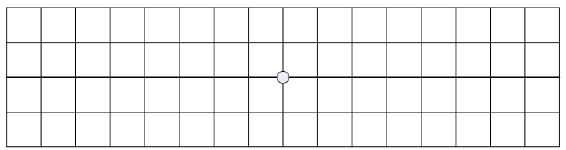
Figure 14. Reservoir pressure distribution at the time of two years.